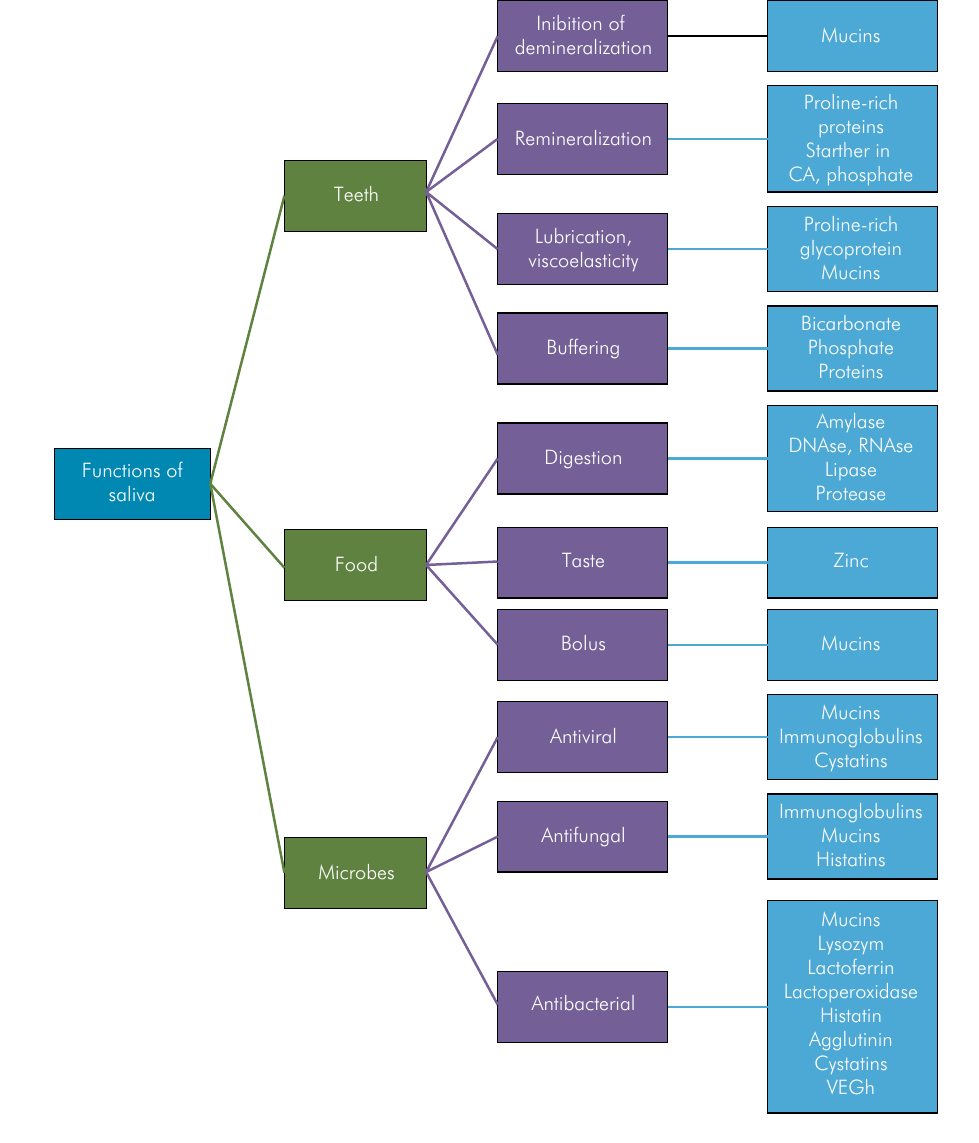
Figure 3. Saliva functions in the oral